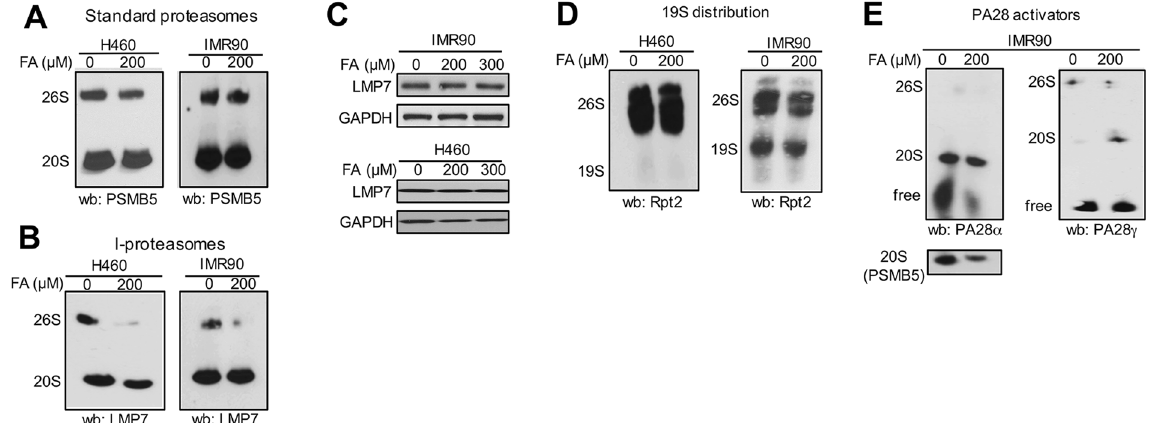
Figure 7. Native gel electrophoresis of proteasomes. H460 and IMR90 cells were treated with 200 μ M FA for 2 h. ( A ) Distribution of standard 20S proteasomes between free and 19S-capped (26 S) forms. ( B ) I-proteasome distribution between free (20S) and 19S-capped (26S) forms. ( C ) LMP7 levels in control and FA-treated cells. ( D ) Distribution of 19 S proteasome between its free and 26S-bound forms. ( E ) Proteasome binding of small activators PA28 αβ (left panel) and PA28 γ (right panel).